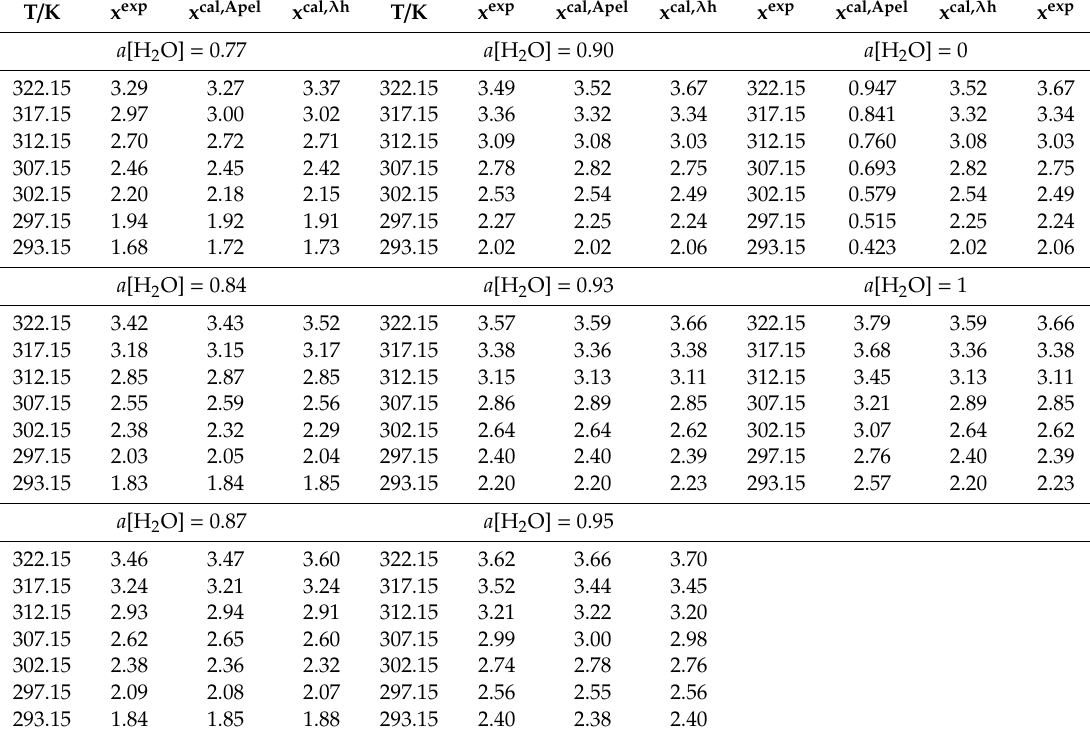
Table 1. Experimental solubility (10 3 x) of L-Phe in methanol-water solvent mixtures with di ff erent water activities.